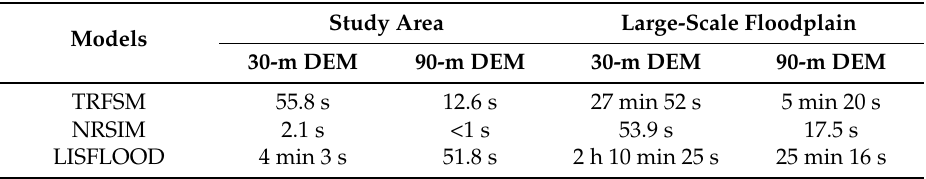
Table 2. Comparison of computational efficiency between NRSIM, TRFSM and LISFLOOD using the computational times when applied to the study area and a large-scale urban